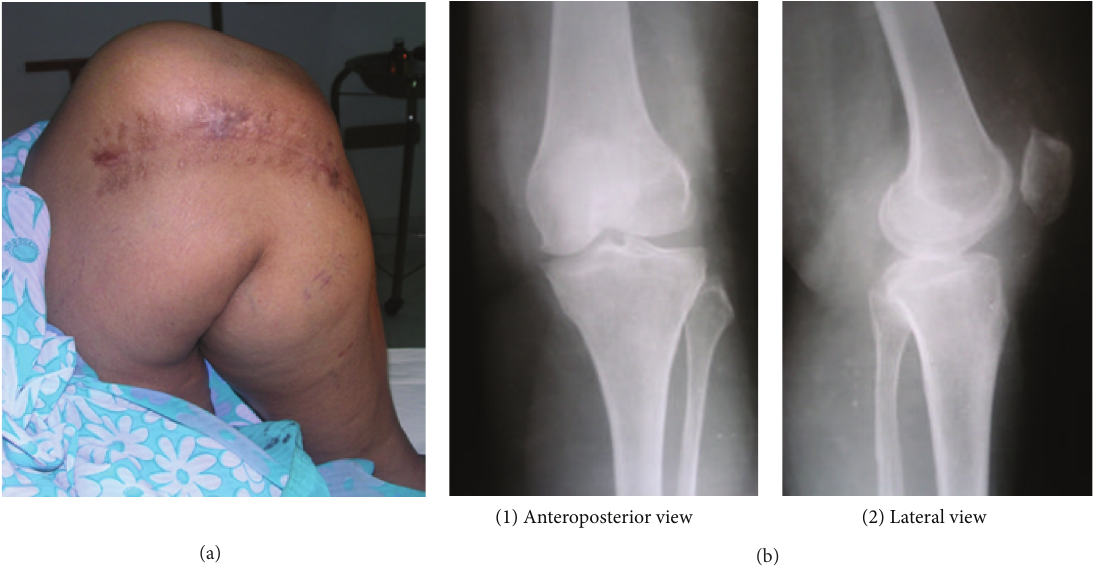
Figure 7: Two-year followup. (a) Clinical photograph and (b) radiology showing no